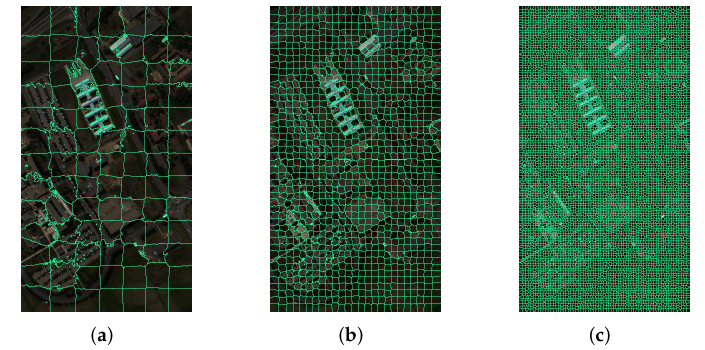
Figure 2. Segmatation maps with different superpixel scale S on University of Pavia. ( a ) S = 91. ( b ) S = 1376. ( c ) S = 6856. ( b ) is a meaningful segmentation scale map. ( a ) is an undersegmentation map. ( c ) is an oversegmentation